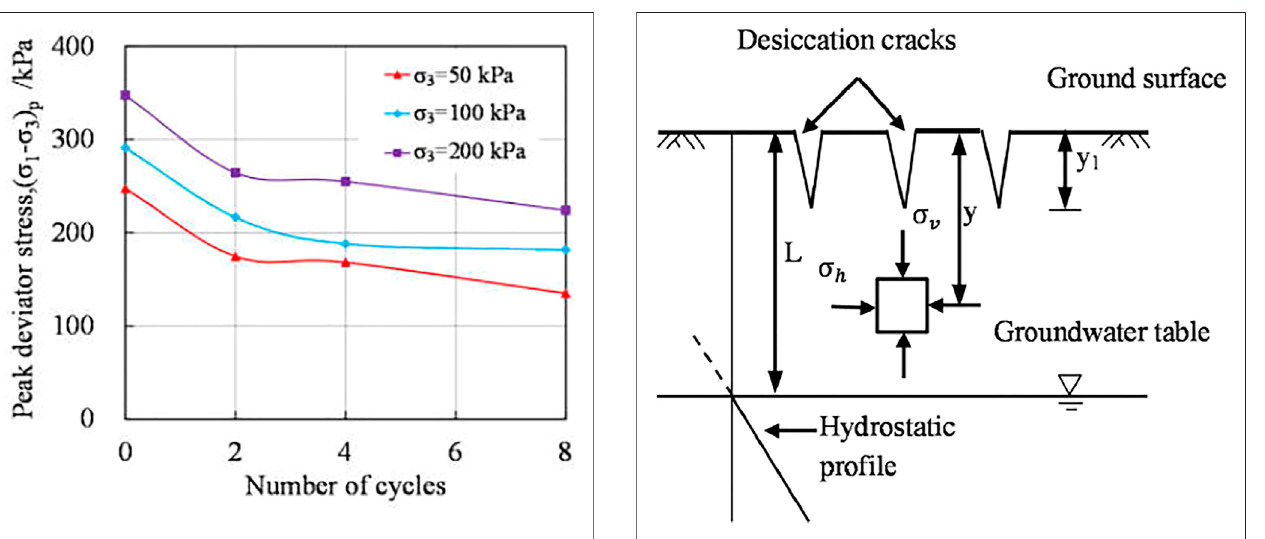
FIGURE 7 | Model of crack development in soil during the drying process.